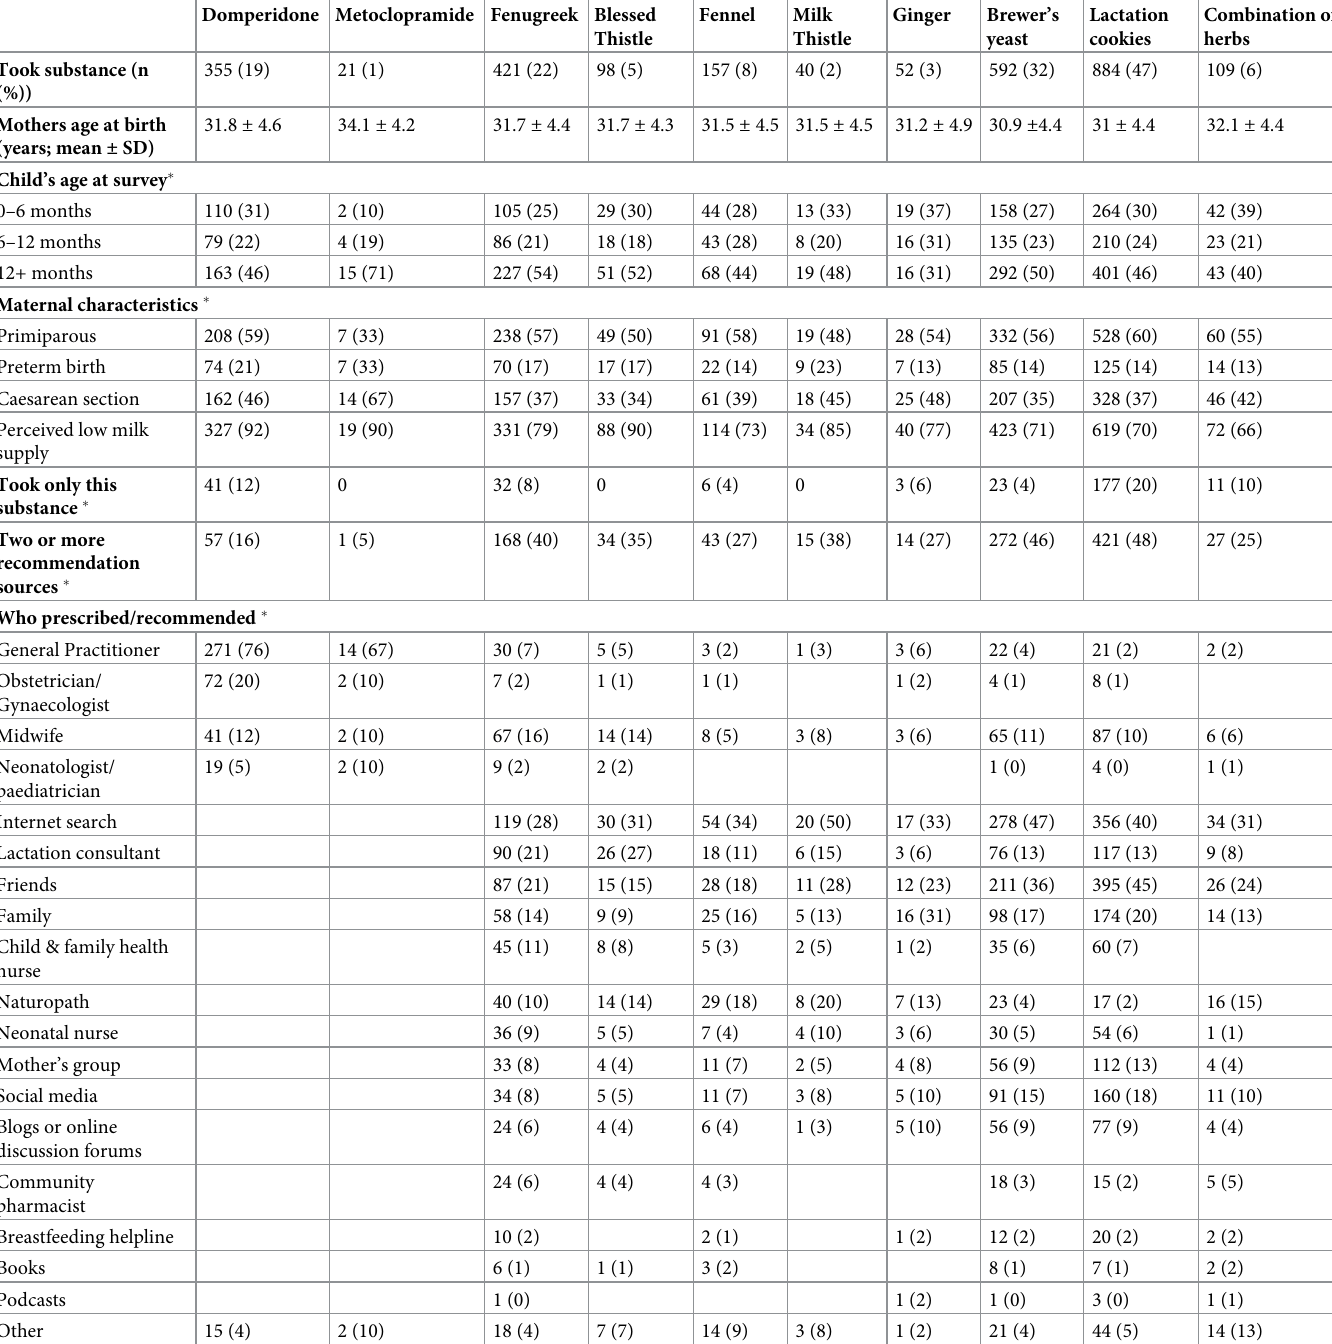
Table 2. Reported use of galactagogues and information sources from breastfeeding women (n = 1876). Domperidone Metoclopramide Fenugreek Blessed